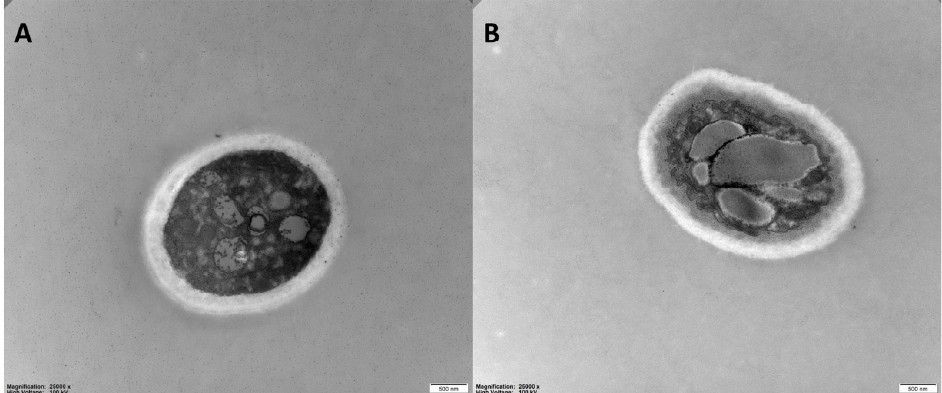
Figure 8. TEM images of V. mali mycelial ultrastructure after 6-methylcoumarin treatment: ( A ) Untreated hyphae (normal control) and ( B ) V. mali treated with 105 mg/L 6-MCM.